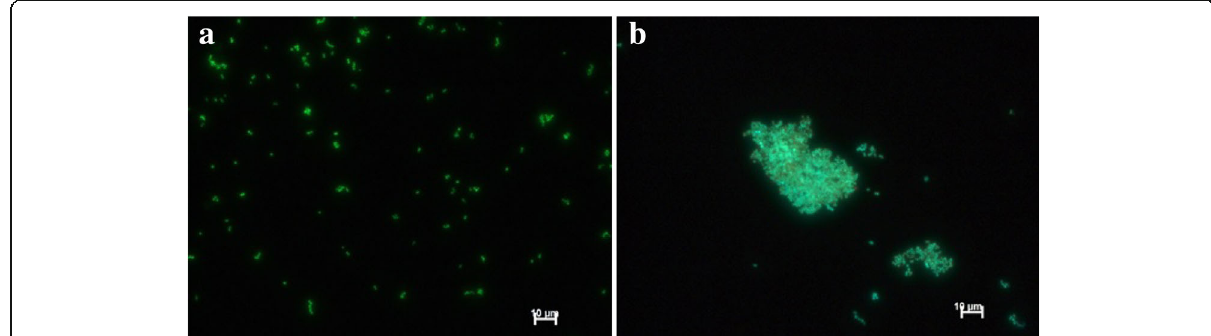
Fig. 8 S. aureus cell culture without nanocomposites ( a ) and the cells embedded in biofilm after incubation with nanocomposites for 24 h ( b ). The scale bar is 10 μ